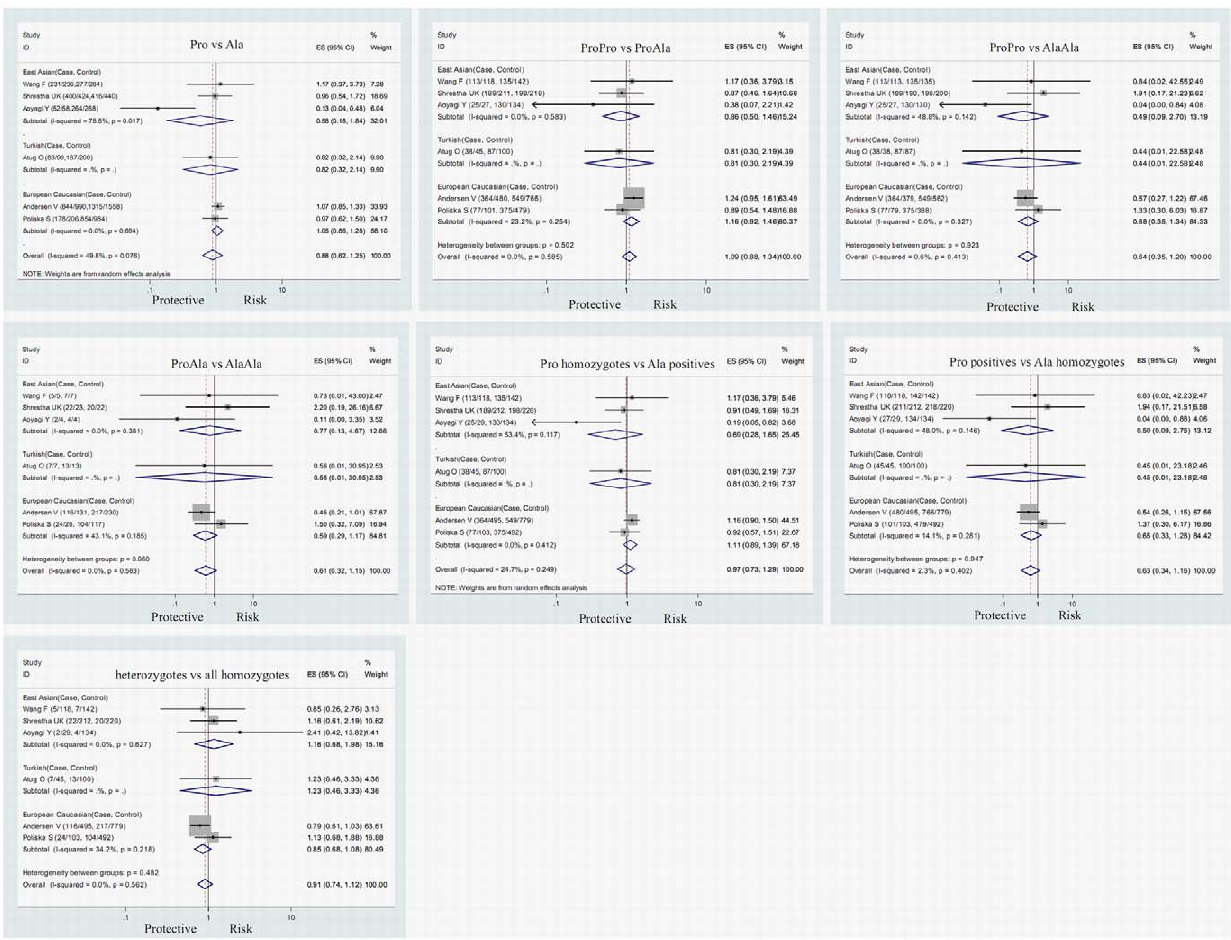
Figure 2. Forest plots for meta-analyses of the association between the PPAR c Pro12Ala mutation and the presence of UC.